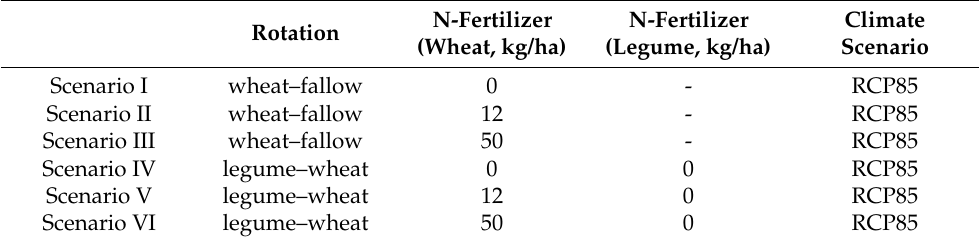
Table 3. Settings of simulation scenarios (1990–2060) for Australian wheat cropping